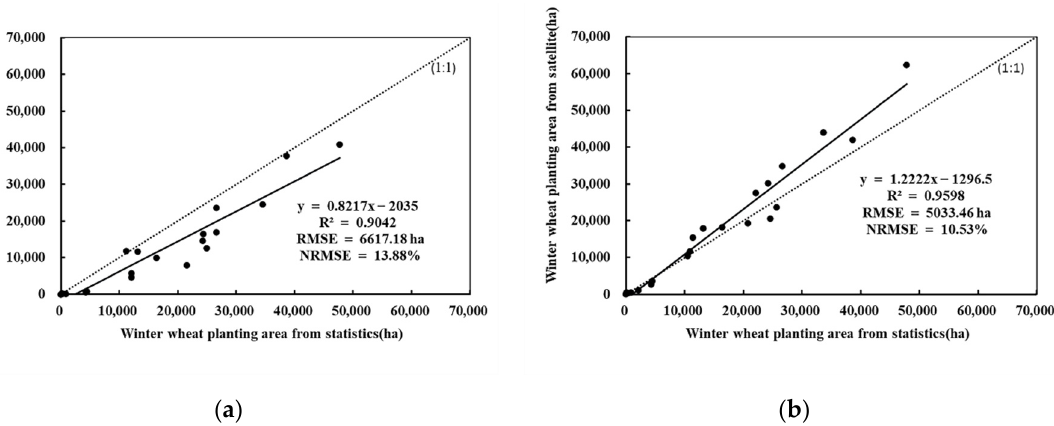
Figure 8. ( a ) The results of the extraction and statistical data of winter wheat in Shijiazhuang in 2018. ( b ) The results of the extraction and statistical data of winter wheat in Shijiazhuang in 2019.